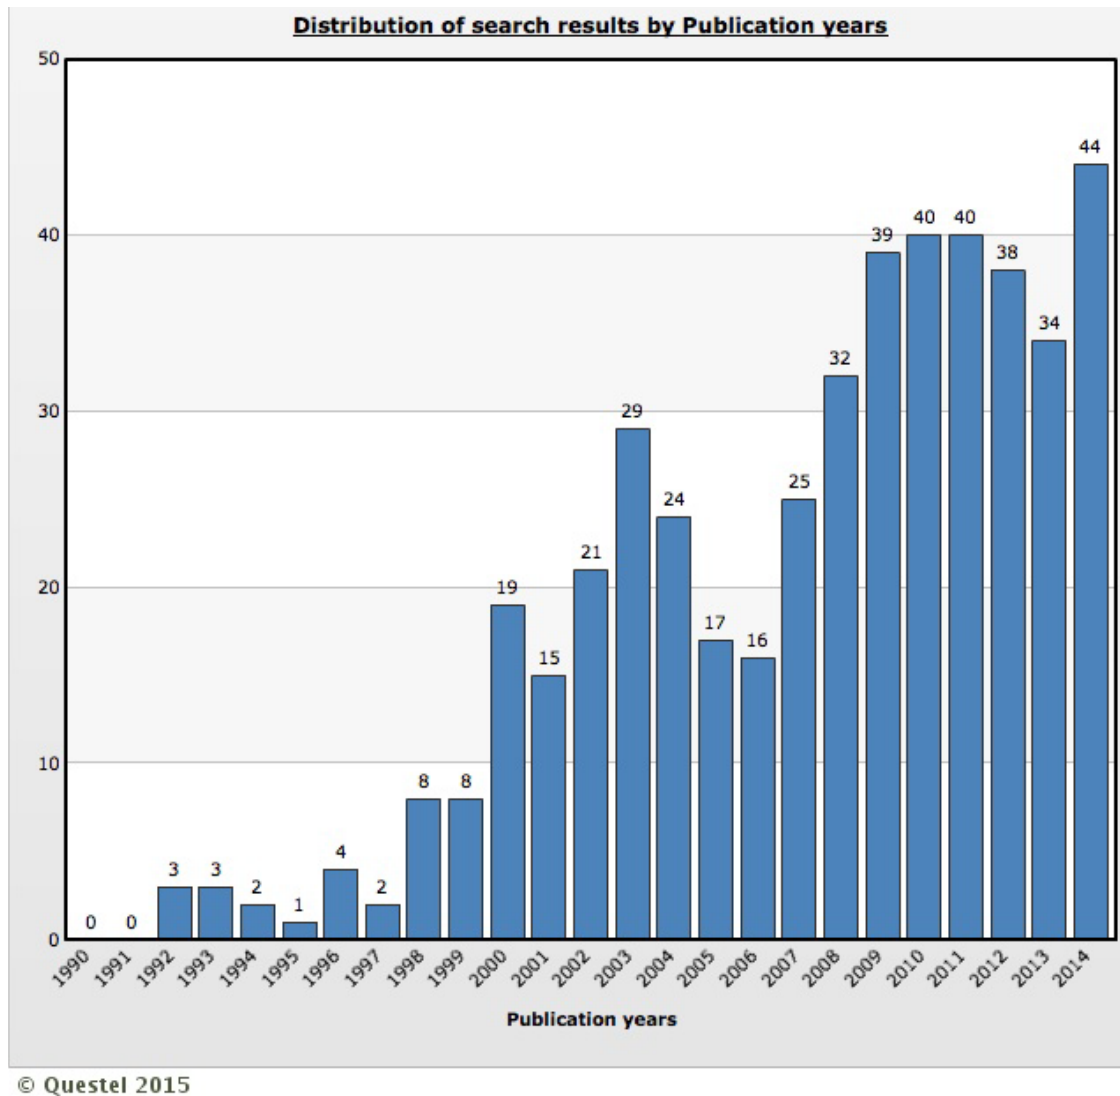
Figure 2. Distribution of number of published patents by publication year from 1990 to